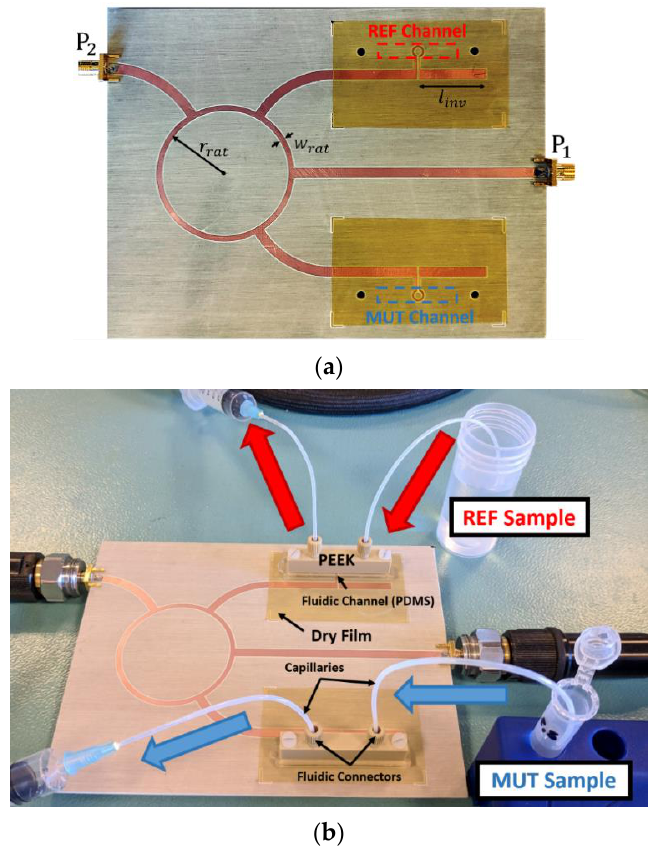
Figure 33. Top view of the sensor topology ( a ) and perspective view of the whole fabricated sensor ( b ). From [69], reprinted with permission.